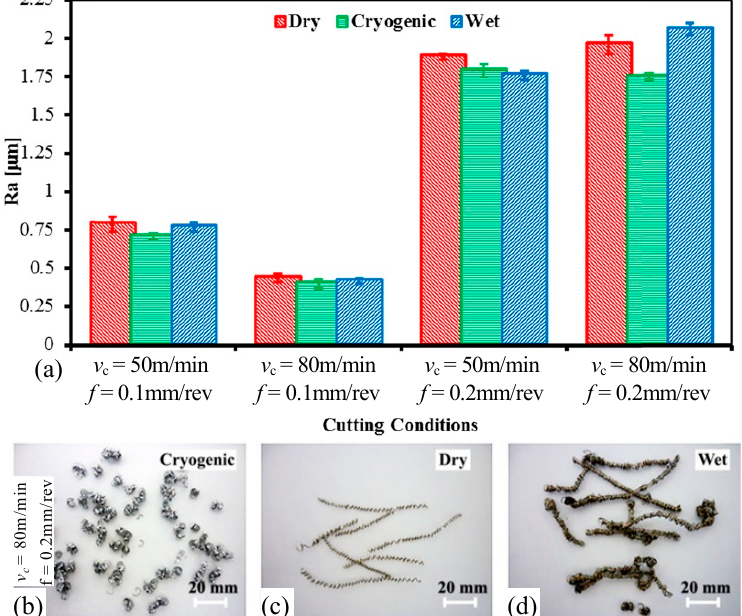
Figure 23. ( a ) Effect of the cooling strategies on the mean surface roughness R a after 8 min of turning. ( b – d ) Chip morphology under cryogenic, dry, and wet turning conditions after 8 min of cutting and for a cutting speed of 80 m/min, adapted with permission from Ref. [158] 2017, Elsevier. Frequent chip entanglements occurred during dry turning. In wet cutting, long tubular chips appear, which damage the tool and workpiece. The chip morphology under cryogenic turning is better.